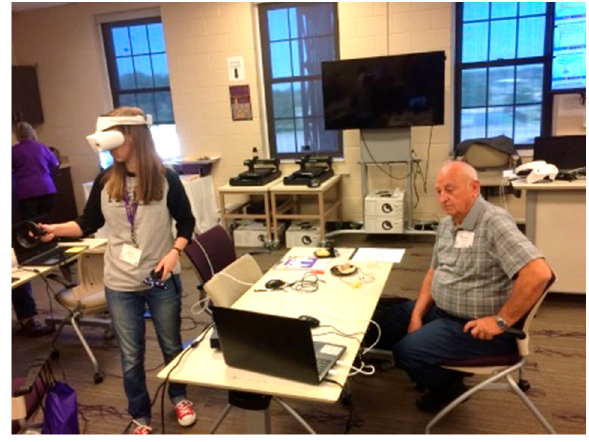
Figure 6. Summer 2019 workshop attendees learning about virtual reality and using DELL Visor headsets.